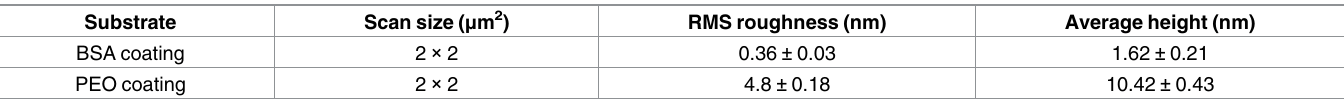
Table 1. RMS roughness and mean height of a BSA-coated glass slide and a PEO-coated glass slide.